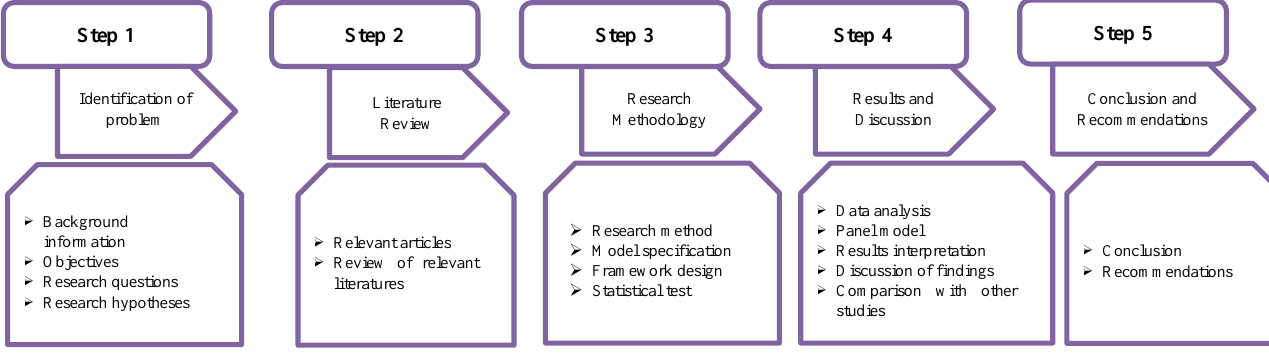
Figure 1. Flow chart of research